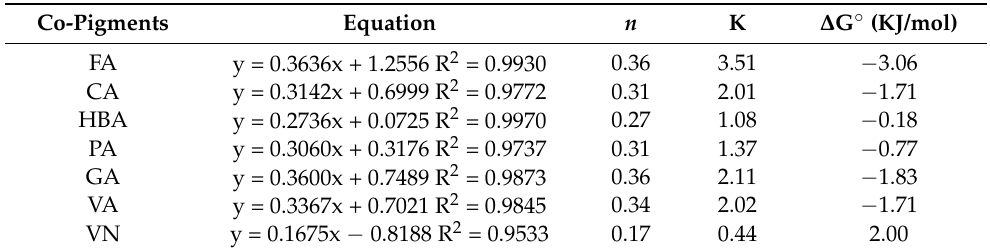
Figure 3. Plot of ln((A-A 0 )/A 0 ) vs. ln(C P ) 0 . Table 1. Thermodynamic properties for the co-pigmentation reactions of mulberry anthocyanin with different co-pigments.